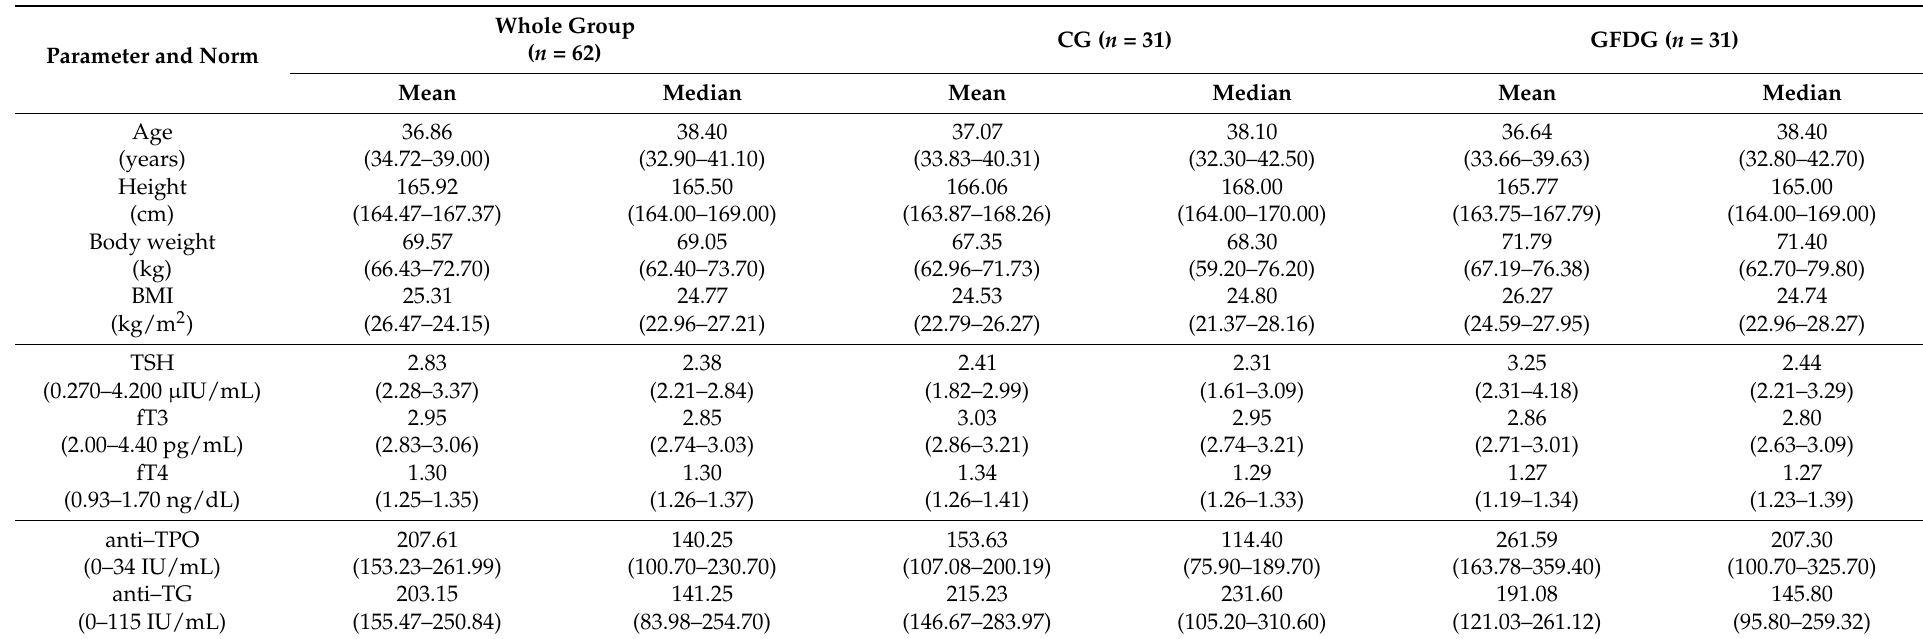
Table 1. Characteristics of the study group ( n =